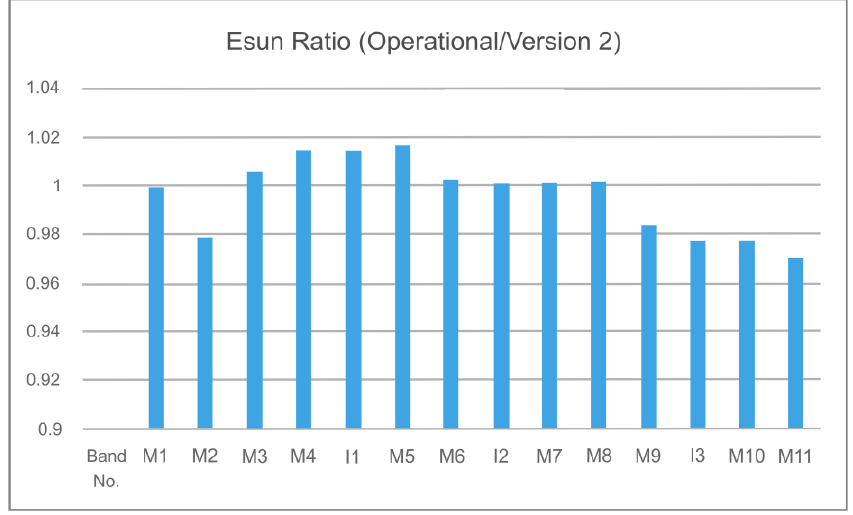
Figure 1. Radiometric biases due to the use of different solar irradiance models (MODTRAN 4.0 vs. Thuillier 2003) vary up to 3%, depending on the channel.